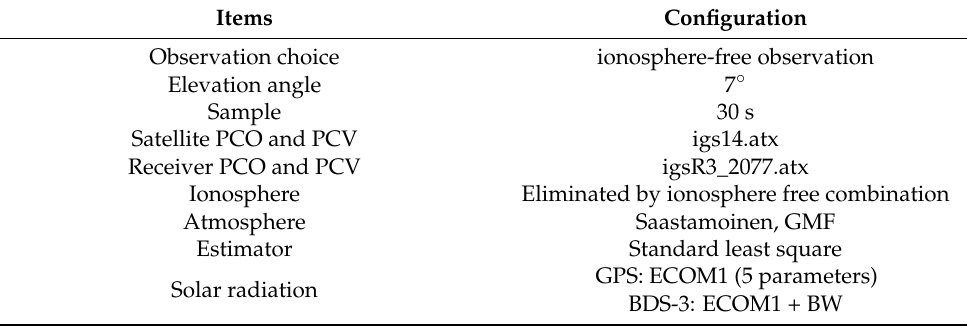
Table 3. The strategy of GPS/BDS-3